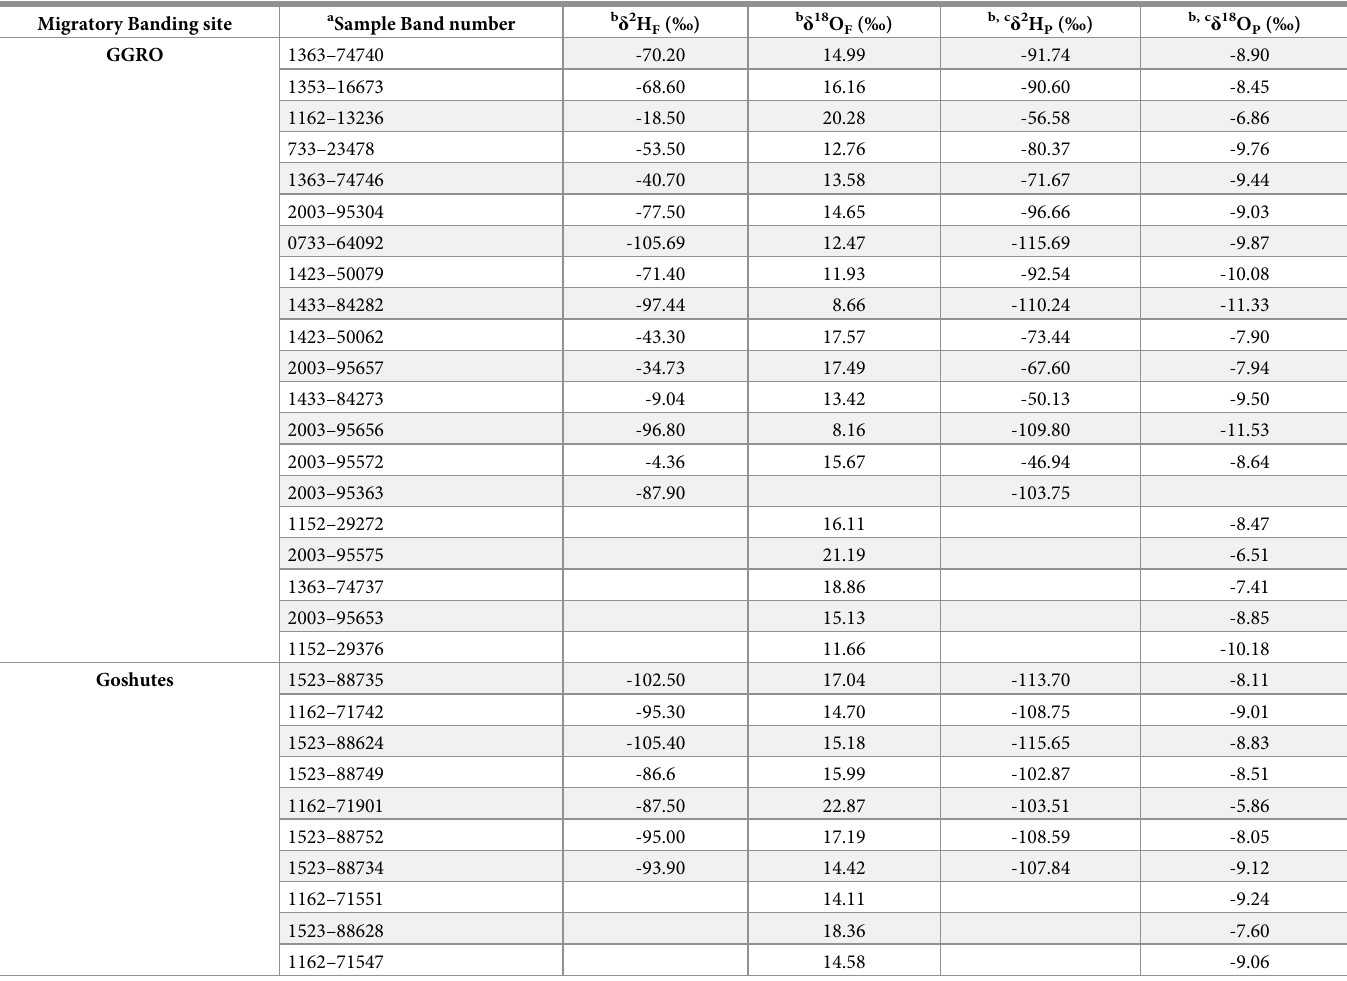
Table 2. Stable hydrogen and oxygen isotope composition of feathers of migrating Sharp-shinned Hawks ( Accipiter striatus ) ( δ 2 H F , and δ 18 O F values (‰)) captured at the Golden Gate Raptor Observatory (GGRO), and at the Goshute Mountains HawkWatch (Goshutes), and of predicted stable hydrogen and oxygen isotope com- position of precipitation ( δ 2 H P and δ 18 O P values (‰)) at the migrant’s unknown natal